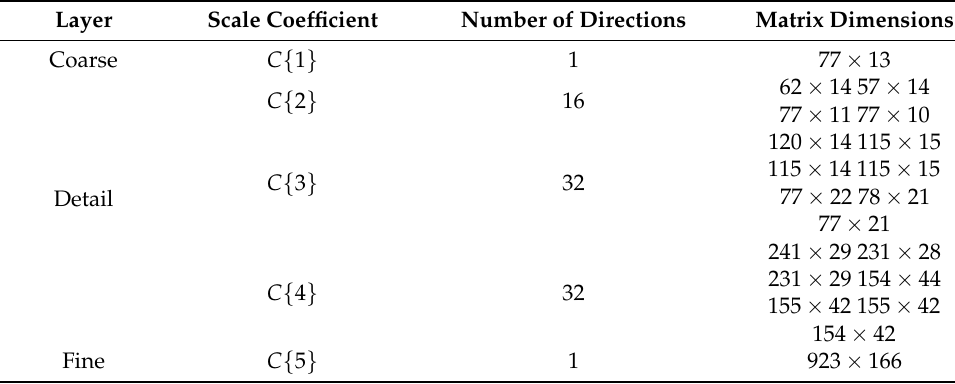
Table 1. Structure of Curvelet transform coefficients.